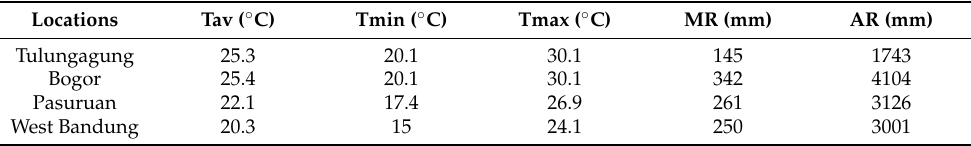
Table 3. Temperature and rainfall of four kaffir lime growing locations.